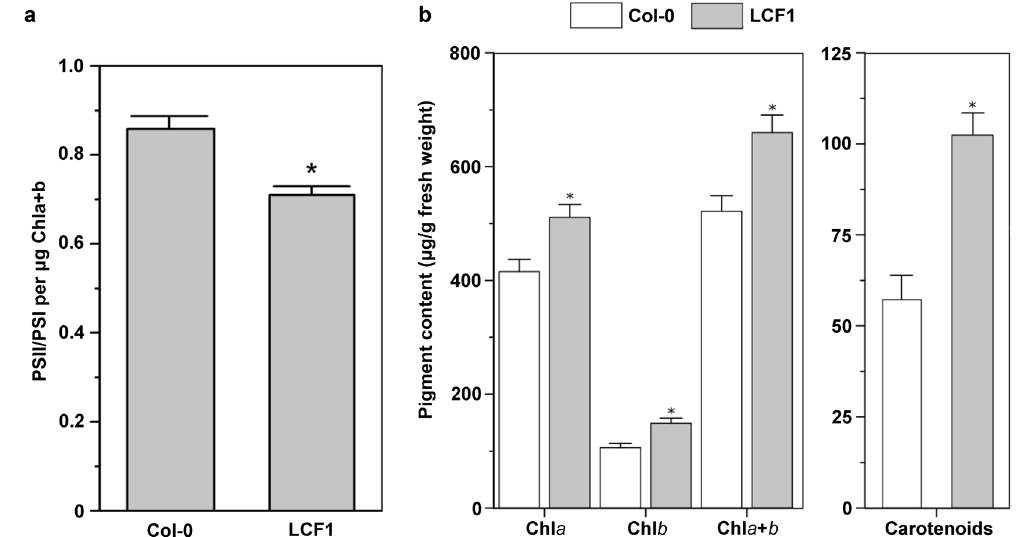
Figure 5. ( a ) The PSII-PSI ratio of Col-0 and LCF1 plants at 28 days after germination, determined by fluorescence spectrophotometry. Error bars represent SEM values (n = 7 per genotype). ( b ) Photosynthetic pigment content of leaves of Col-0 and LCF1 plants. The chlorophyll and total carotenoid contents were determined spectrophotometrically. Asterisks ( * ) represent a significant difference with Col-0 after one-way ANOVA ( p < 0.05). Error bars represent SEM values (n = 7 per